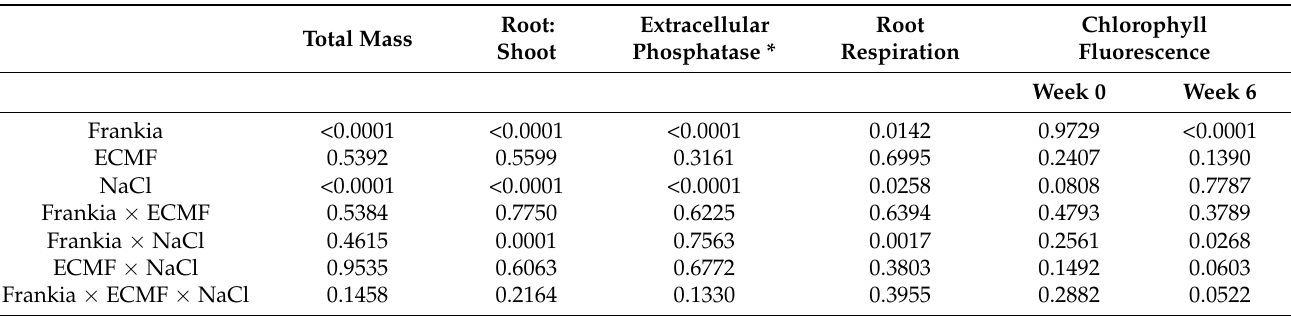
Table 1. p values from least squares models of the effect of Frankia , ECMF, and salt exposure on plant performance.